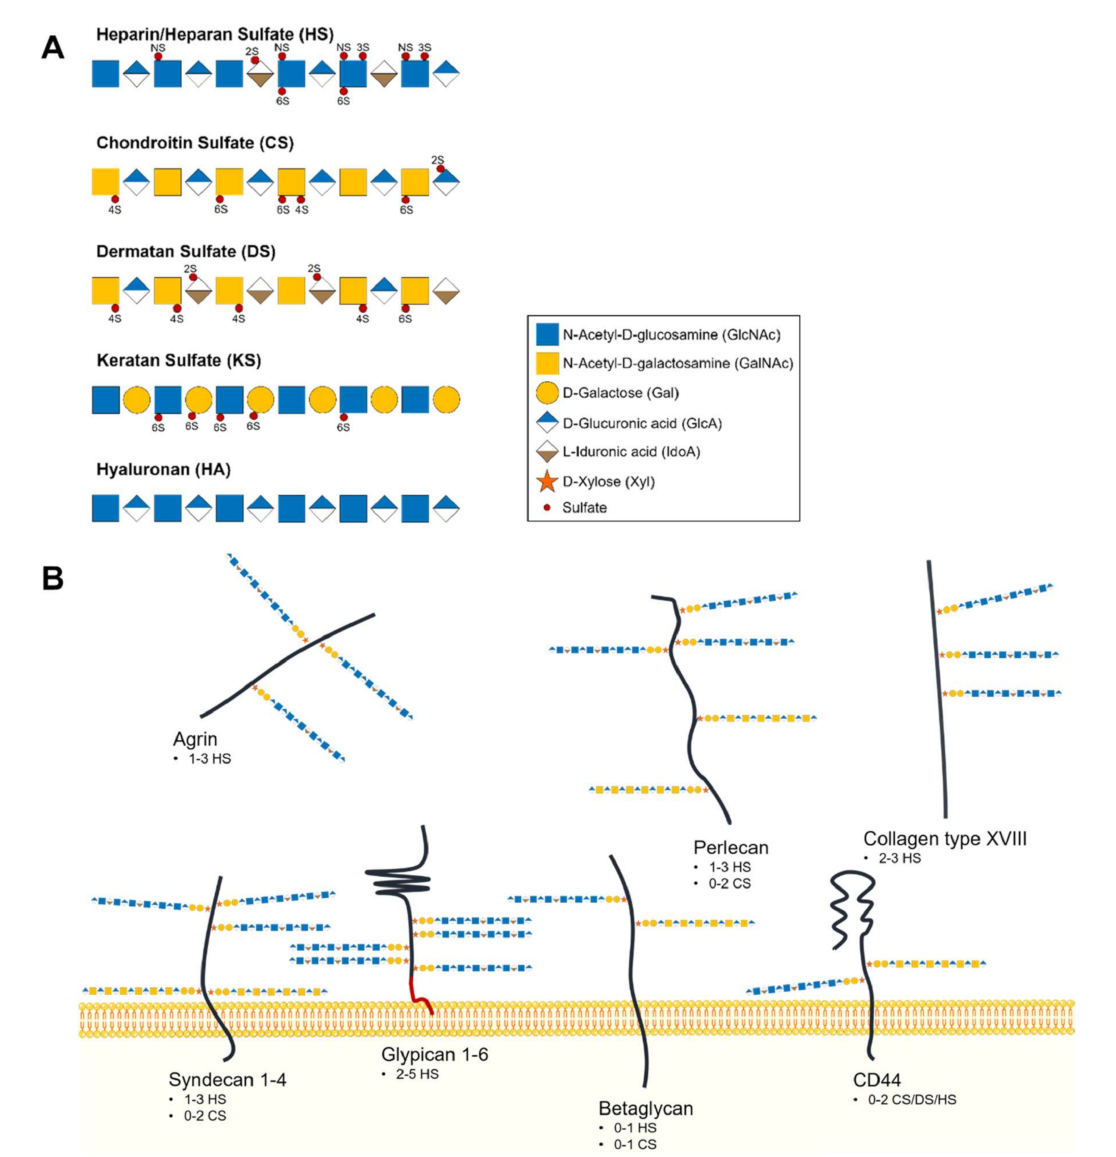
Figure 1. ( A ) Structural composition and classification of glycosaminoglycan chains. Non-reducing termini are to the right of the saccharide’s sequences. ( B ) Illustrative representation of major heparan sulfate (HS)-proteoglycans composing the cells’ glycocalyx and extracellular matrix (ECM). Below each family of heparan sulfate proteoglycans (HSPGs) is indicated the number and type of glycosaminoglycan (GAG) chains that commonly modify the core protein